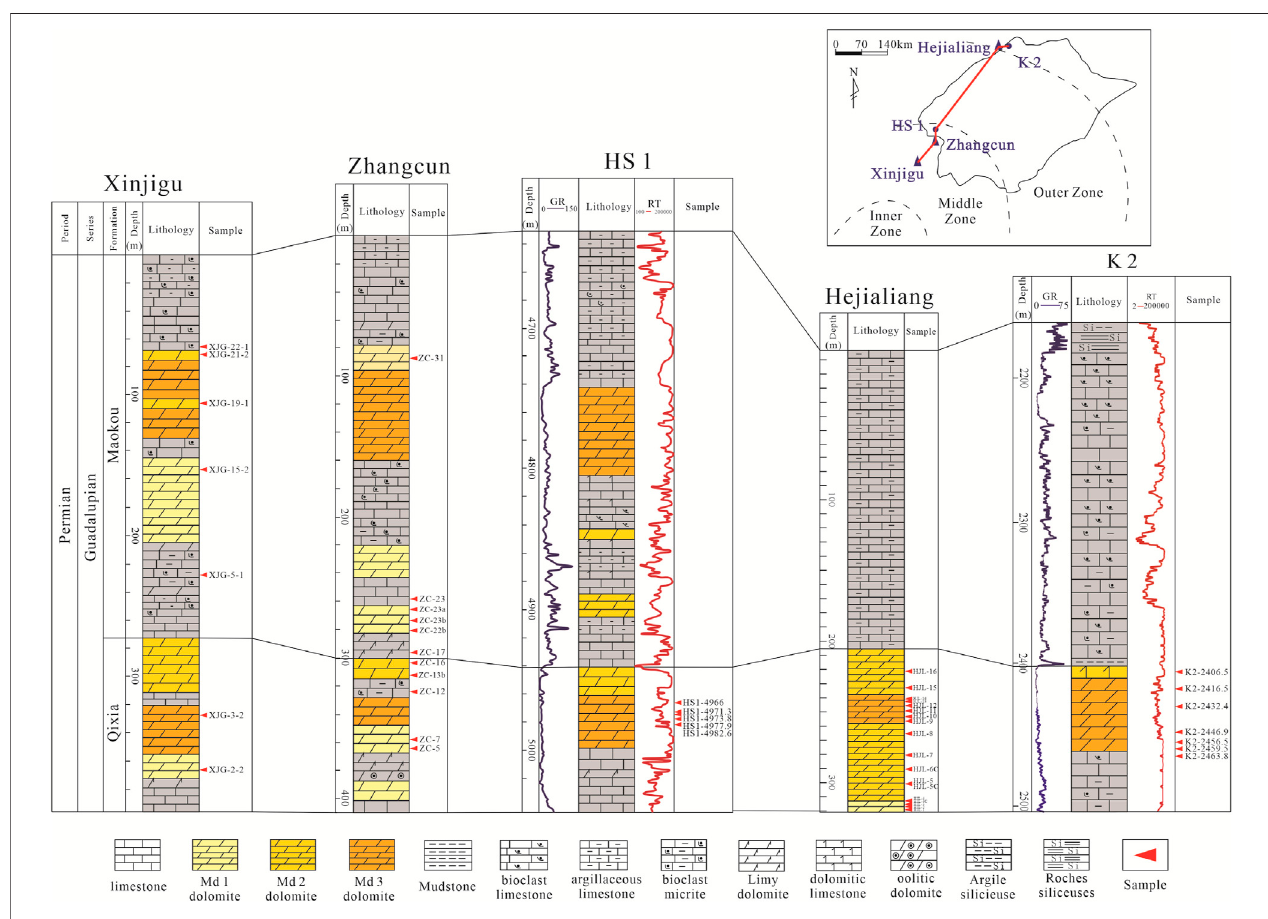
FIGURE 3 | Stratigraphic correlation of Middle Permian in the study area, showing the distribution of dolomites and samples.